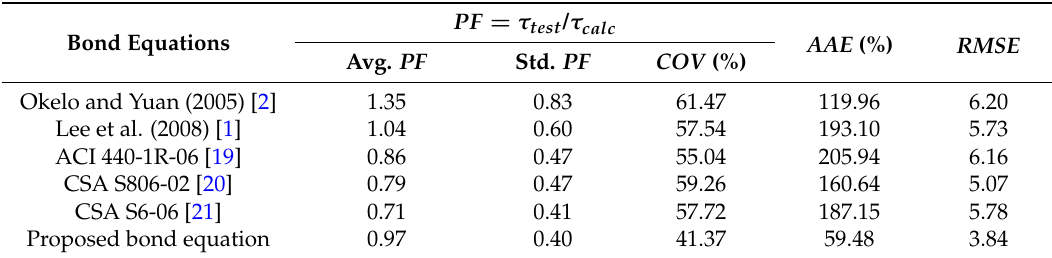
Table 3. Comparison of bond equations for the first group.